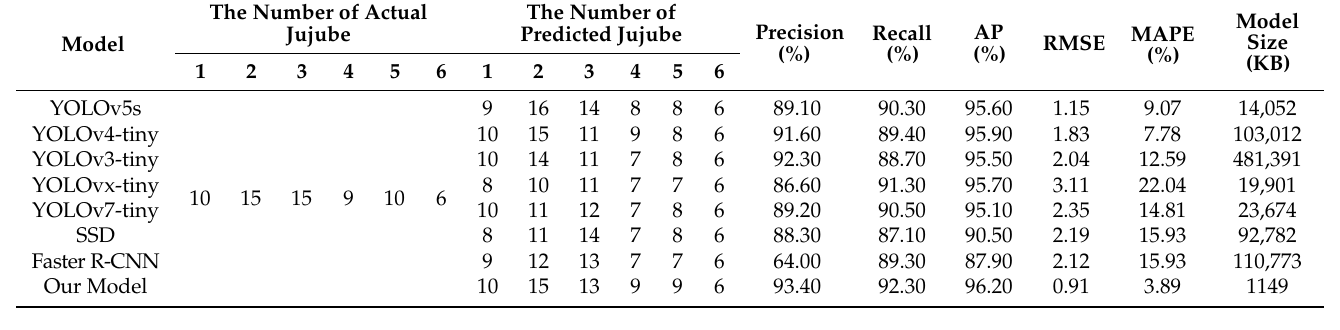
Table 4. the comparison of different backbone networks.